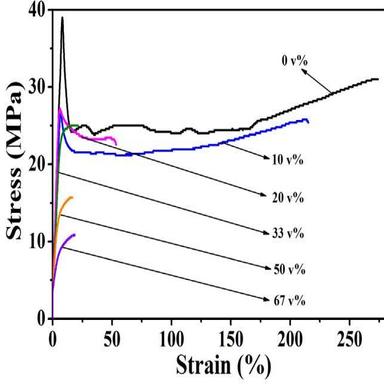
Stress–strain curves of PVC films and PVC porous films.